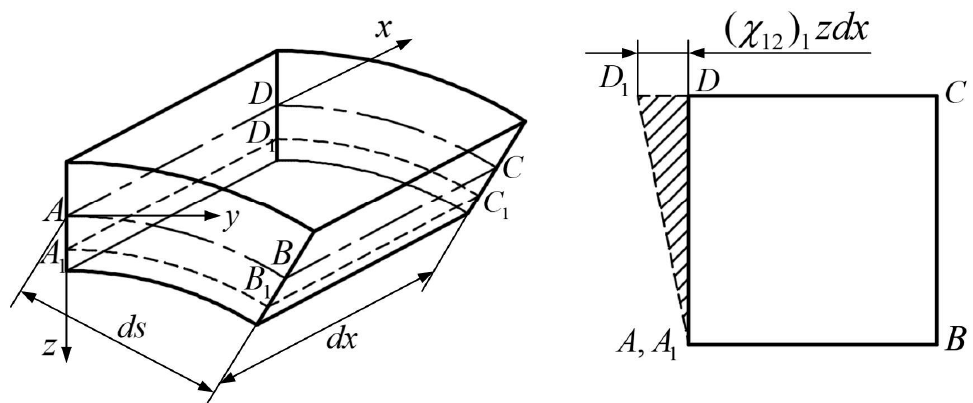
Figure A4. The shell unit deformation force analysis.